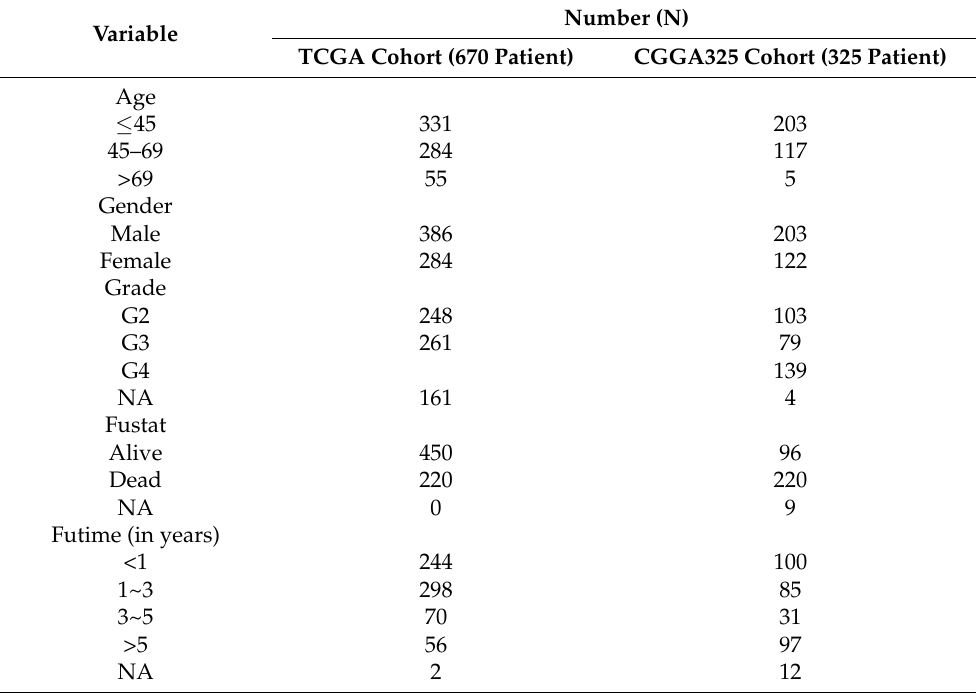
Table A1. The baseline clinical data.